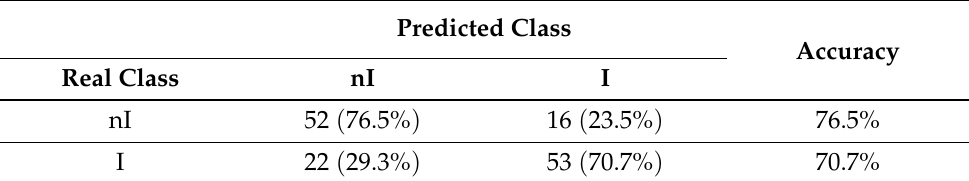
Table 7. Confusion matrix of the female prediction model. Accuracy is presented for each class (I and nI).